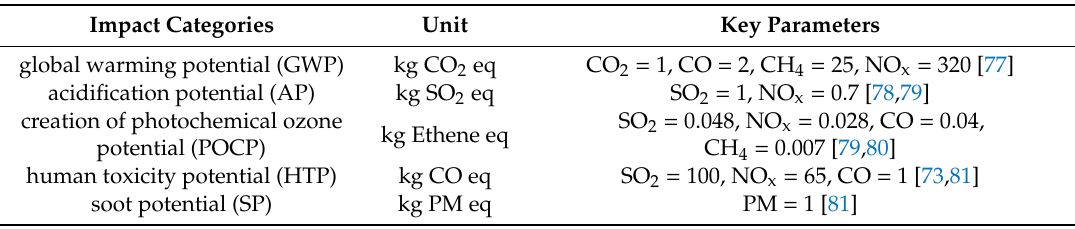
Table 2. Characterization of each impact category.